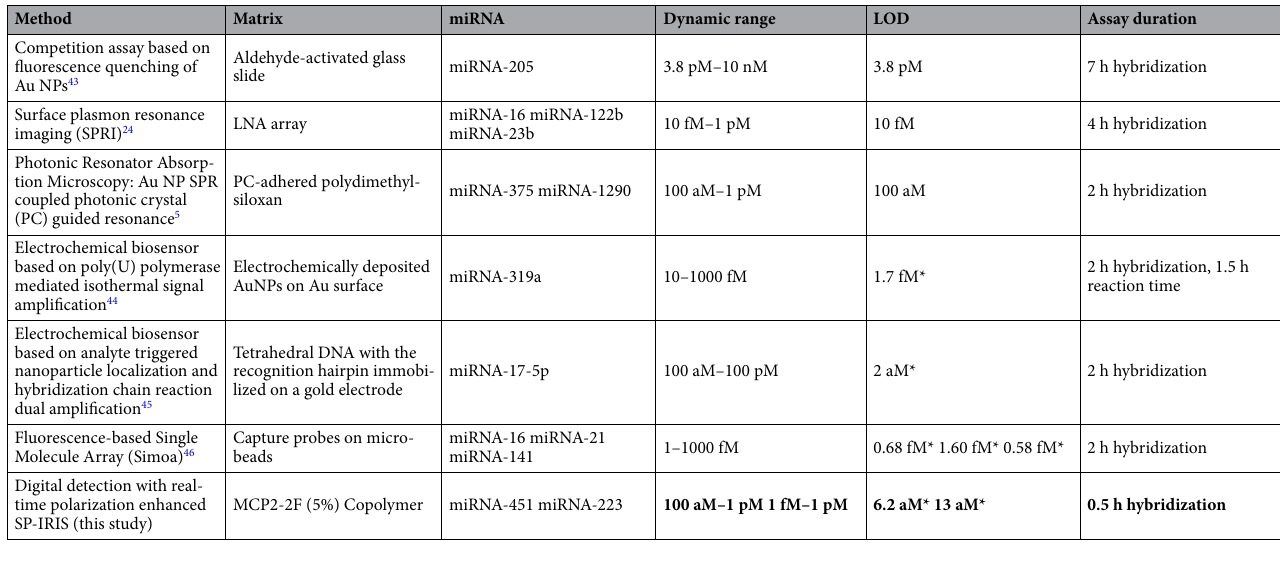
Table 2. Comparison of current miRNA detection techniques. *Denotes the calculated LOD levels by extrapolation below the lowest measured concentration. Significant values in this study are in bold.